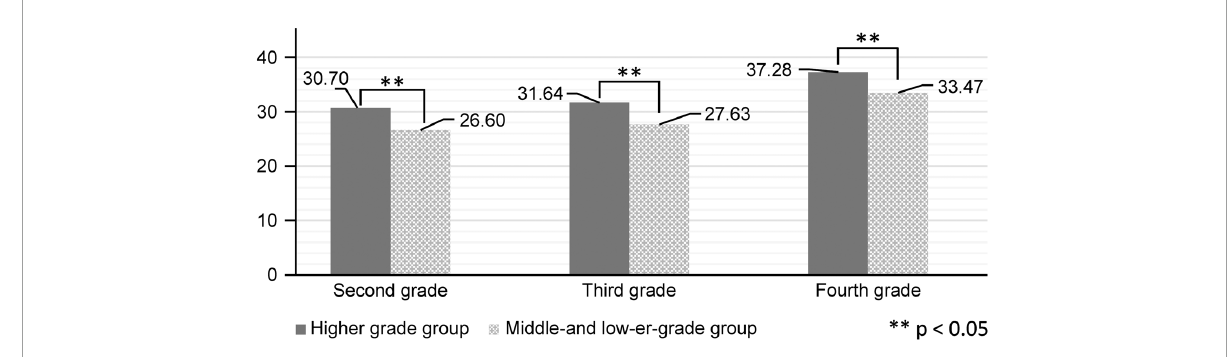
FIGURE3 Arts and crafts and repeated side jump task.